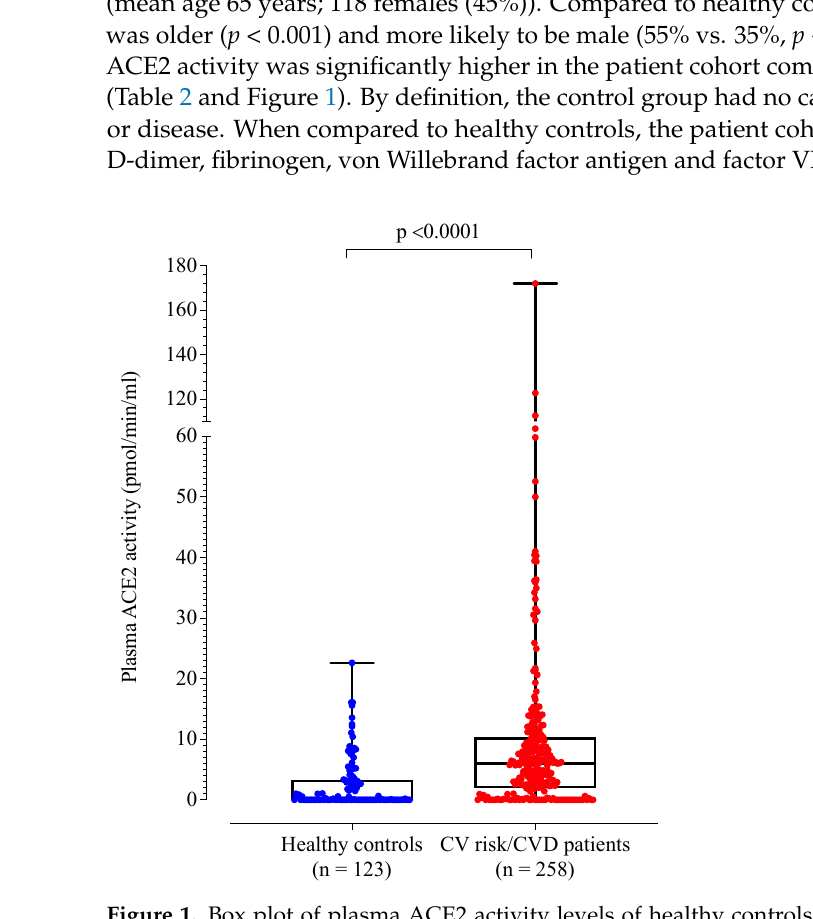
Figure 1. Box plot of plasma ACE2 activity levels of healthy controls compared to patients with cardiovascular risk factors and/or disease. Table 2. Healthy controls compared to patients with cardiovascular risk factors/disease.